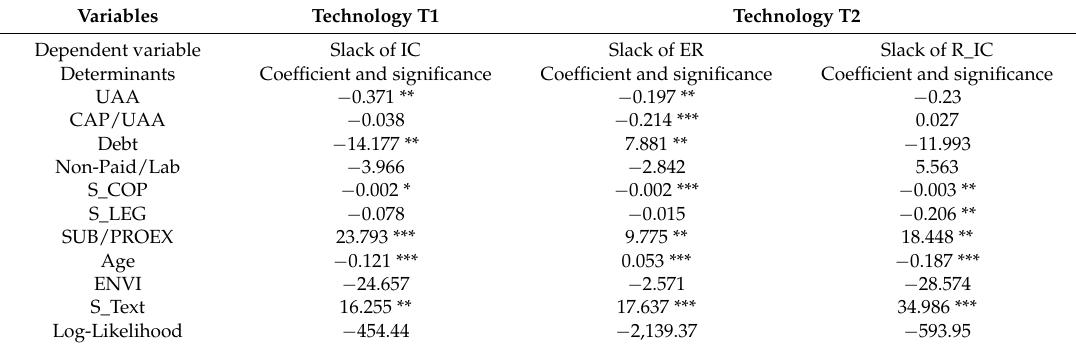
Table 12. Determinants of input slacks for mixed